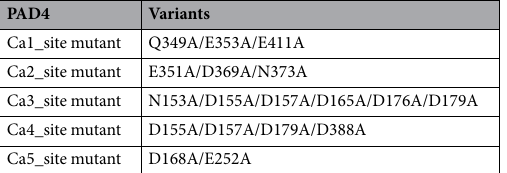
Table 1. Mutations of the PAD4 enzyme at the Ca1-, Ca2-, Ca3-, Ca4- and Ca5-binding sites.